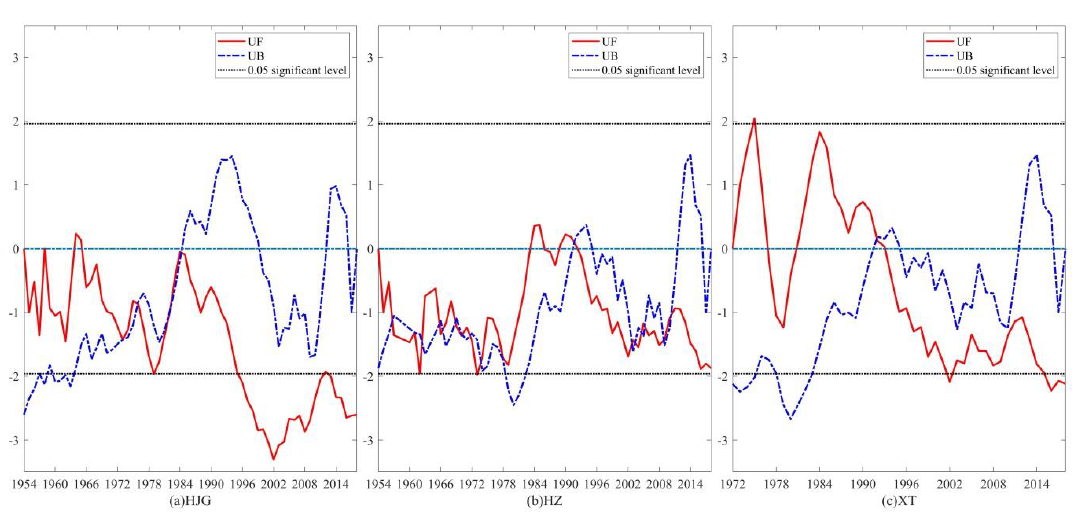
Figure 4. Mann–Kendall test for the annual discharge in three stations along the middle-lower reaches of the Hanjiang river.